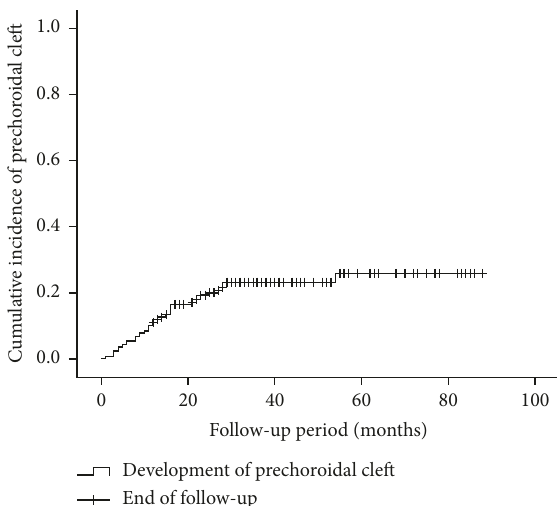
Figure 2: A Kaplan–Meier graph showing the cumulative in- cidence of prechoroidal